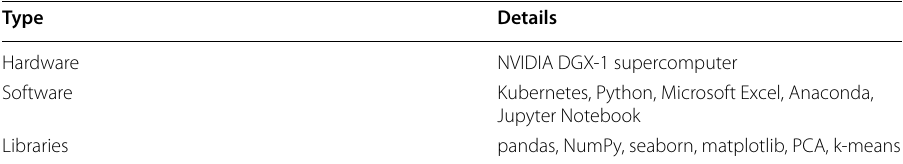
Table 1 Experimental environment